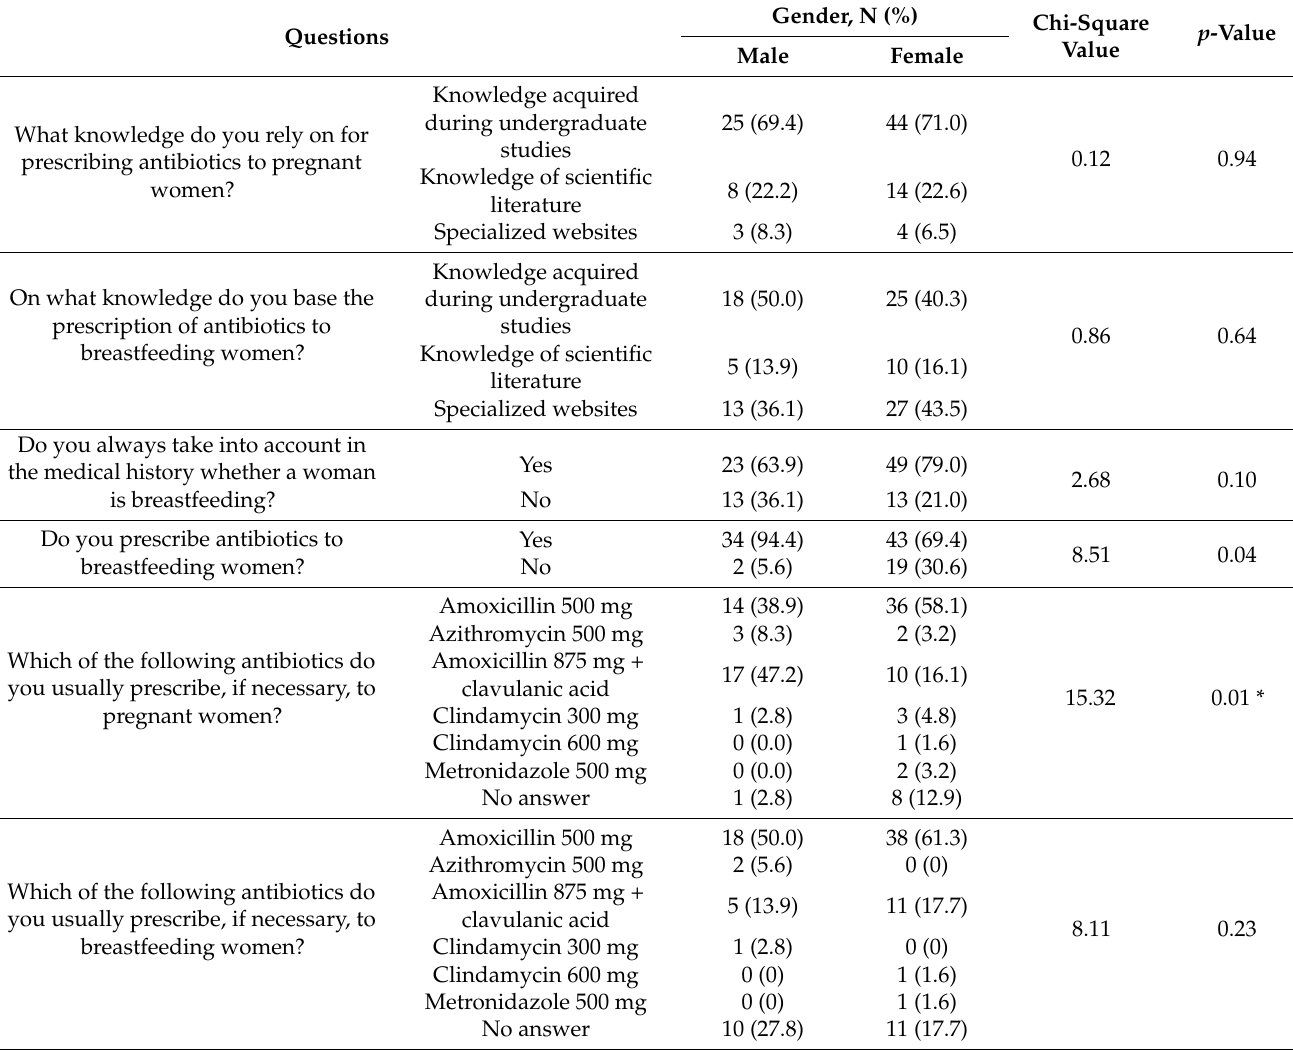
Table 3. Chi-square test for associations between gender and knowledge, attitude, and practice questions.